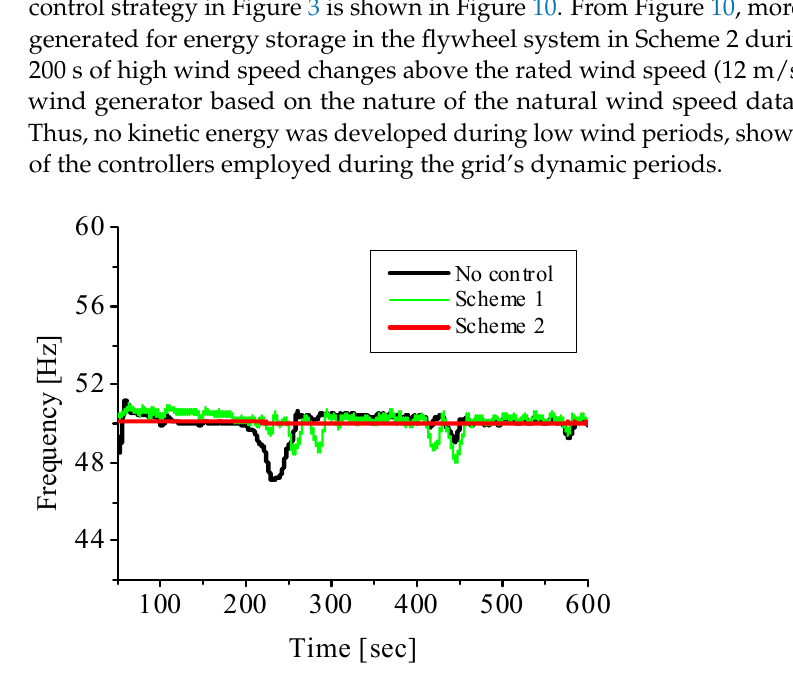
Figure 9. Comparative study of grid frequency response without proper PI controller tuning.